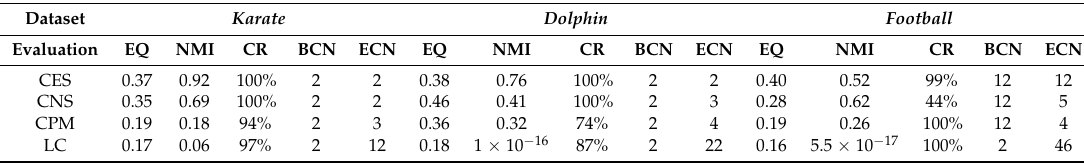
Table 3. The evaluation results of four overlapping community detection (OCD) algorithms (CES, CNS, clique percolation method (CPM), and link clustering (LC)) on three benchmark networks ( Karate Network , Dolphin Network, and Football Network